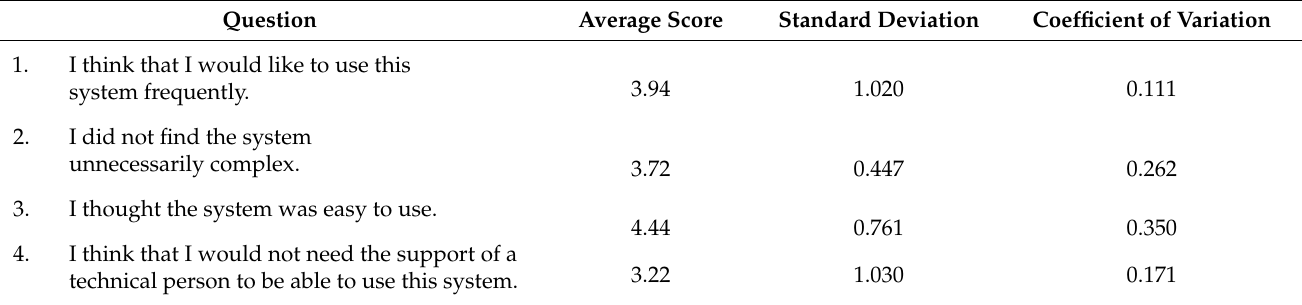
Table 1. SUS questionnaire with resulting average